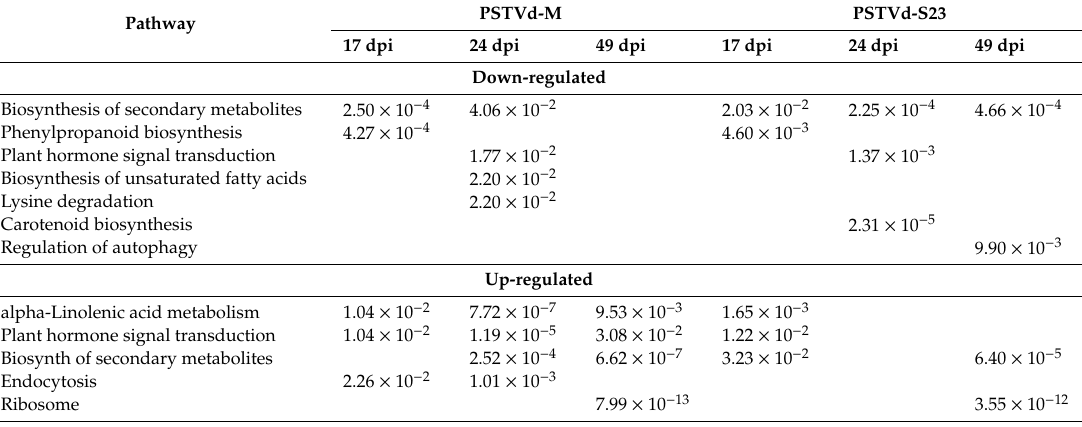
Table 1. Enriched Kyoto Encyclopedia of Genes and Genomes (KEGG) pathway from microarray analysis.